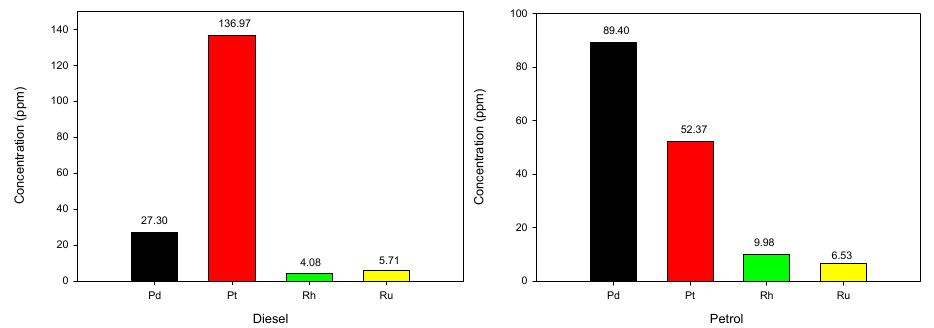
Figure 6. Leach solution analysis of platinum group metals from the diesel and petrol spent catalytic converters.